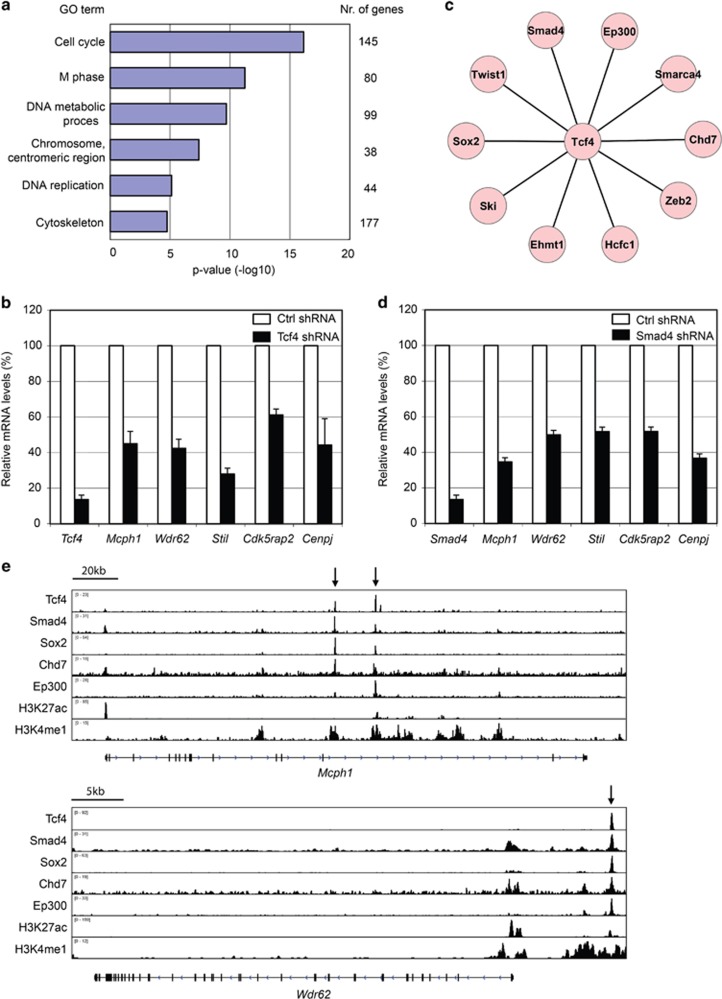
Gene regulation by Tcf4 and its interaction partners. (a) Gene Ontology (GO) analysis of putative Tcf4 target genes. Ranking is by Bonferroni-corrected P-value. P-value (as −log10) and number of Tcf4 target genes in each category is indicated. (b and d) Regulation of primary microcephaly genes by Tcf4 (b) or by Smad4 (d), Relative mRNA levels by RT-PCR of indicated genes in NSCs treated with the indicated shRNAs, s.e.m. of three independent experiments is indicated. (c) Interaction network of Tcf4 with network transcription factors that are associated with microcephaly. (e) Binding site profile of indicated transcription factors and indicated histone modification profiles at Mcph1 (upper panel) or Wdr62 (lower panel). Angpt2, internal to Mcph1 and not regulated by Tcf4, is not indicated. Ep300, H3K4me1 mark enhancers, H3K27ac marks active enhancers, arrows mark transcription factor co-localization. mRNA, messenger RNA; NSC, neural stem cell; shRNA, short hairpin RNA.